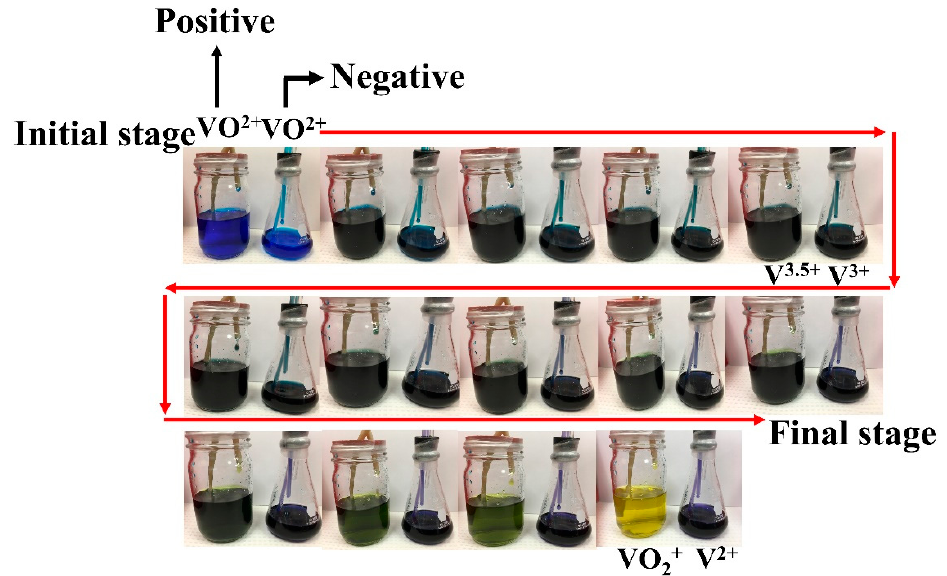
Figure 4. The change in electrolyte colors on the positive and negative sides